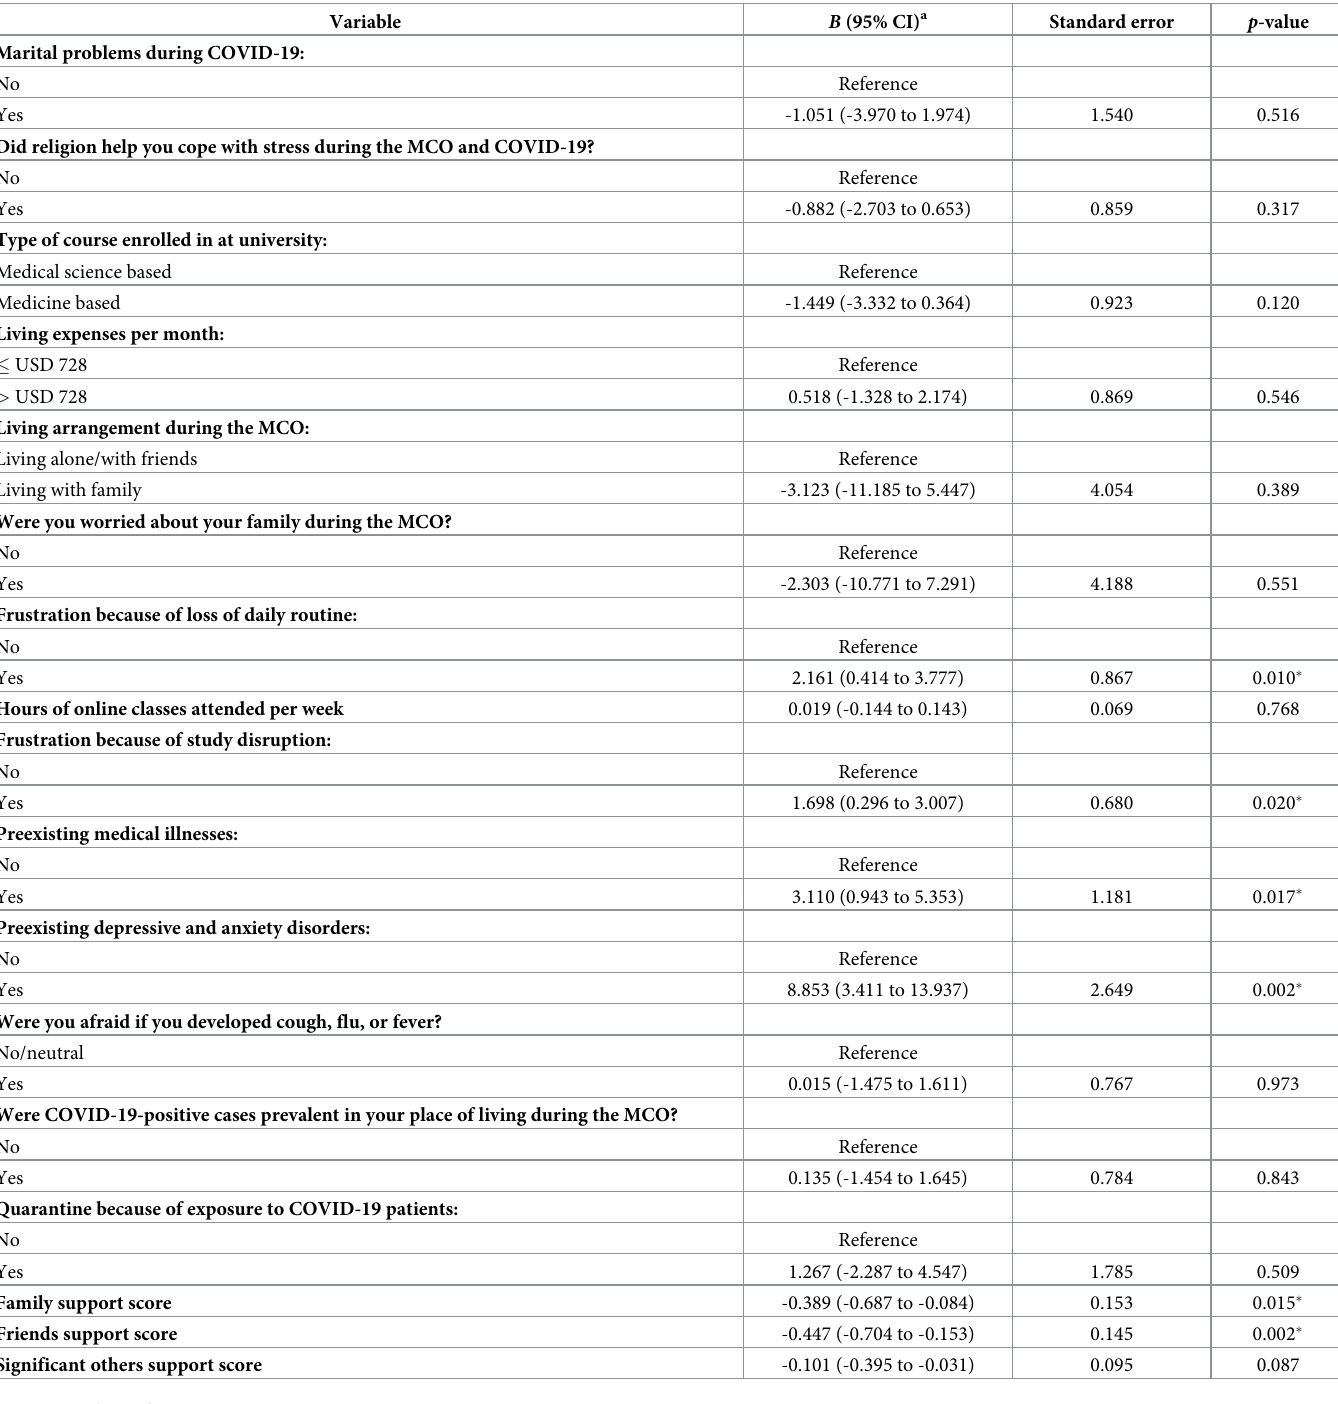
Table 3. Association between various COVID-19 stressors, religious coping, personal and clinical factors, and social support on one hand and the level of depressive symptoms on the other among the